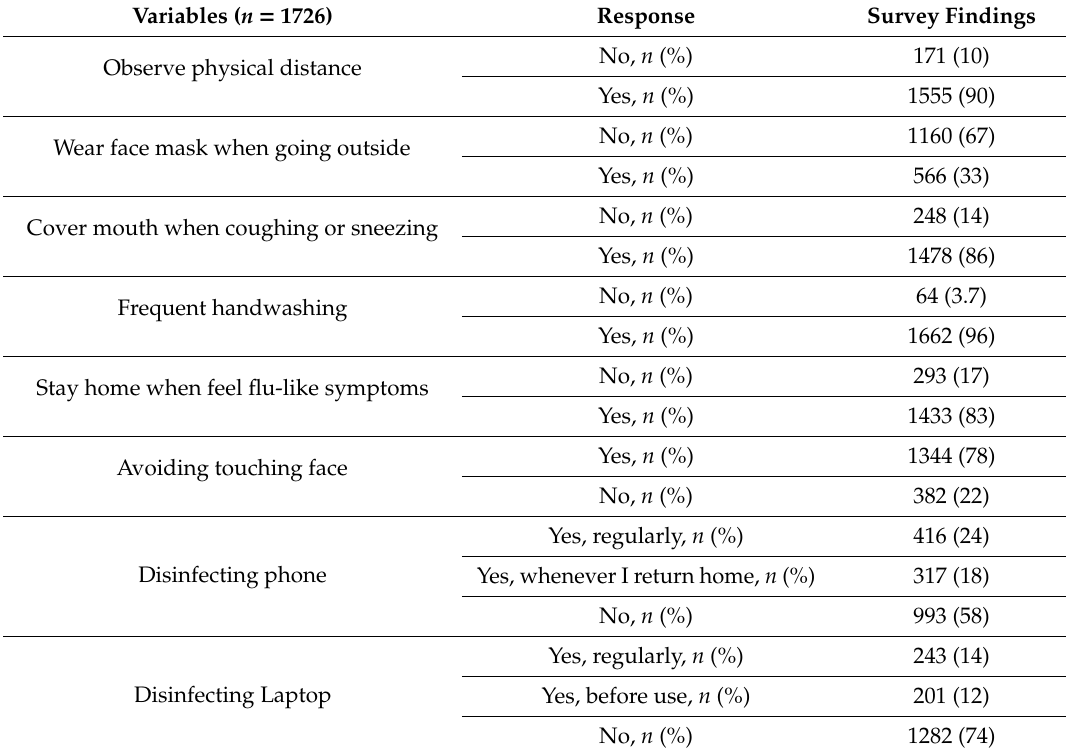
Table 2. Level of adherence to Coronavirus Disease 2019 (COVID-19) preventive measures. Variables ( n = 1726) Response Survey